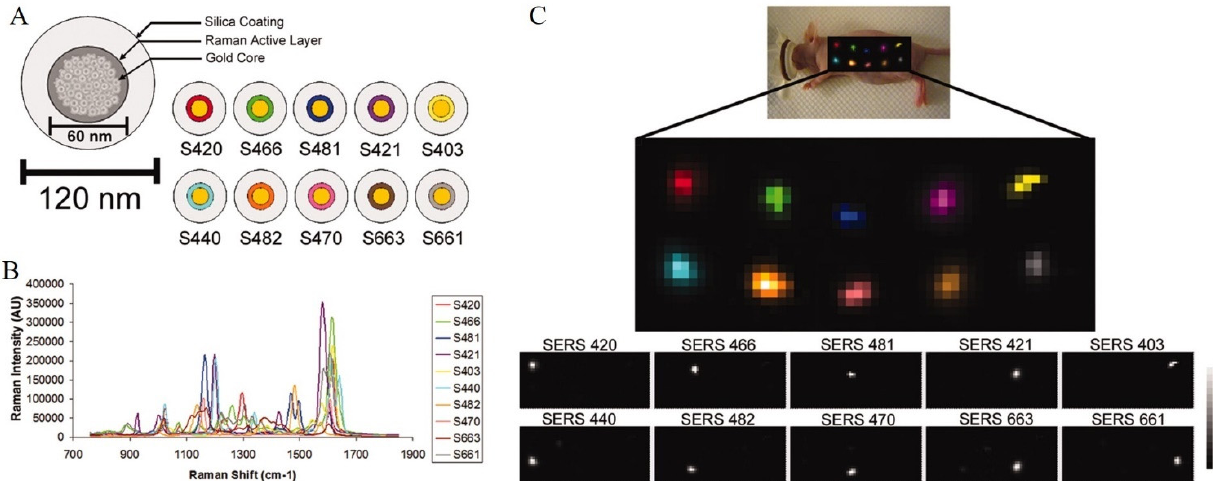
Figure 5. Schematic representation of SERS multiplexing possibilities with the use of 10 different Raman reporters. ( A ) Schematic of a SERS nanosensor consisting of a 60-nanometer gold core with a unique Raman active layer adsorbed onto the gold surface and coated with glass, totaling 120 nm in diameter. The trade name of each SERS nanoparticle is depicted on the right, where a color has been assigned to the Raman active layer of each SERS nanoparticle. ( B ) Graph depicting Raman spectra of all 10 SERS nanoparticles. ( C ) Raman map of 10 different SERS particles injected s.c. into a nude mouse. Reproduced with permission from [38]. Copyright 2009 National Academy of Sci- ences.